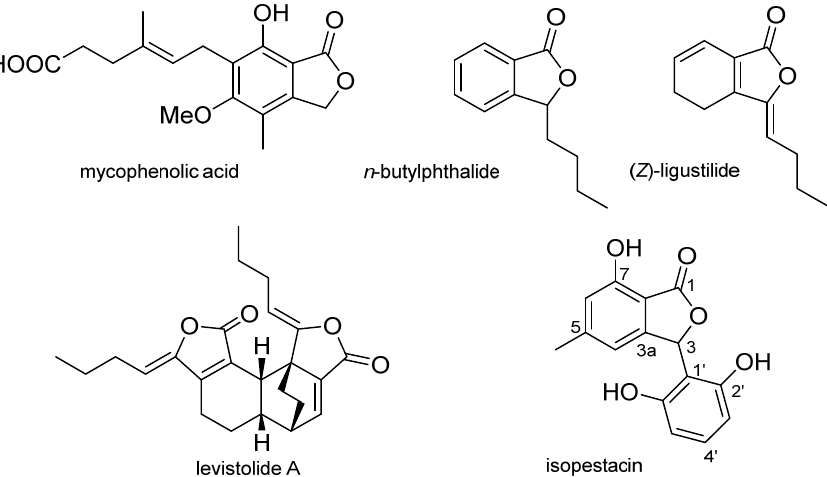
Figure 1. Representative examples of structural diversity of bioactive phthalides.